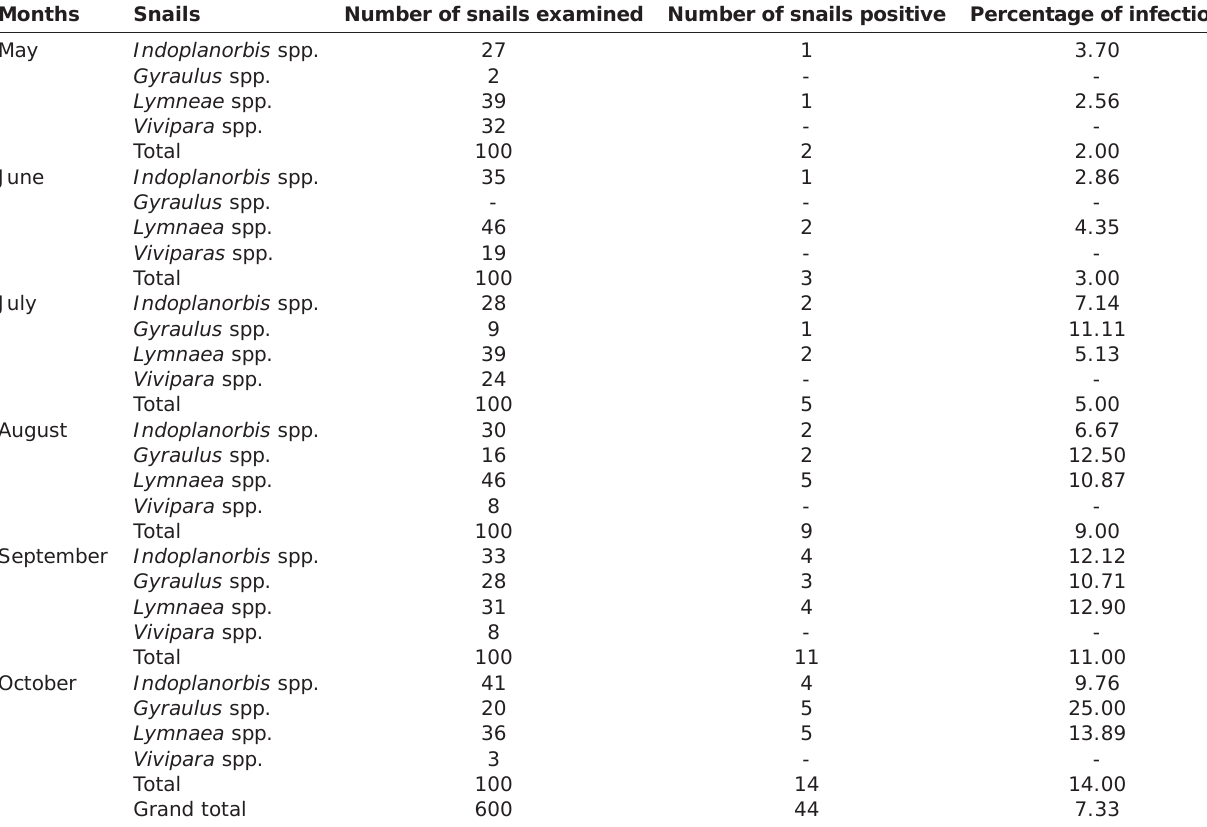
Table-1: Percentage of parasitic infection in different snails in and around Ranchi. Months Snails Number of snails examined Number of snails positive Percentage of infection